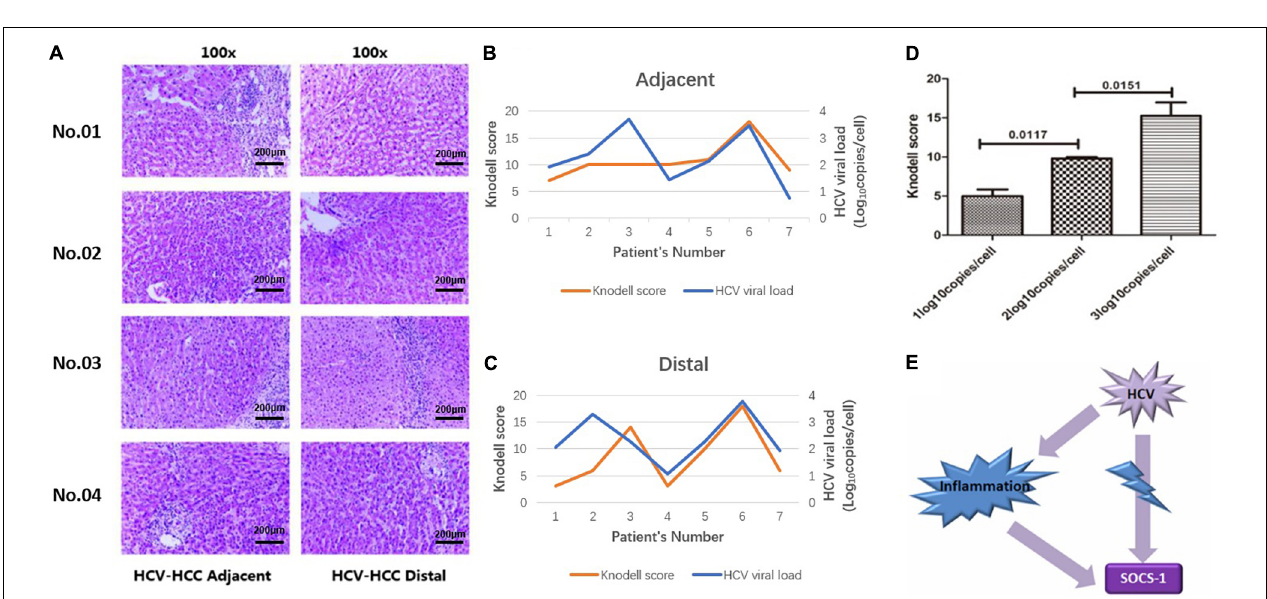
FIGURE 1 | Immunohistochemical staining of suppressor of cytokine signaling 1 (SOCS-1) in different kinds of liver tissues. (A) Representative images of stained SOCS-1 in normal liver tissue, HCV–HCC tissues, HCV–HCC adjacent tissue, and HCV–HCC distal tissue (scale bar = 50 µ m in 400 × images, 200 µ m in 100 × images). (B) Axiotis scores of SOCS-1 expression in liver tissues. The enrolled tissues included 10 HCV-HCC tissues, seven adjacent tissues, and seven distal tissues. Also, 16 normal liver tissue sections were obtained as control (Mann–Whitney U test).